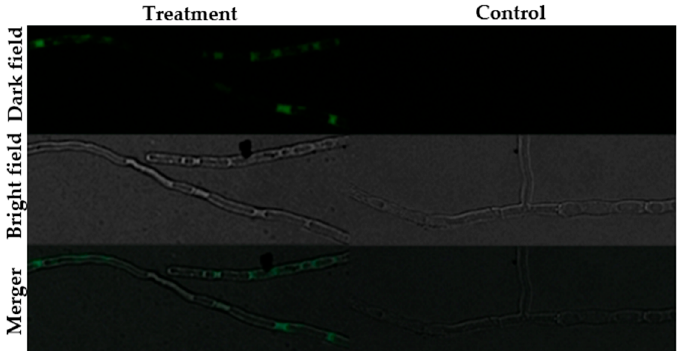
Figure 6. Increase in ROS production of Mycosphaerella arachidicola caused by BGAP.